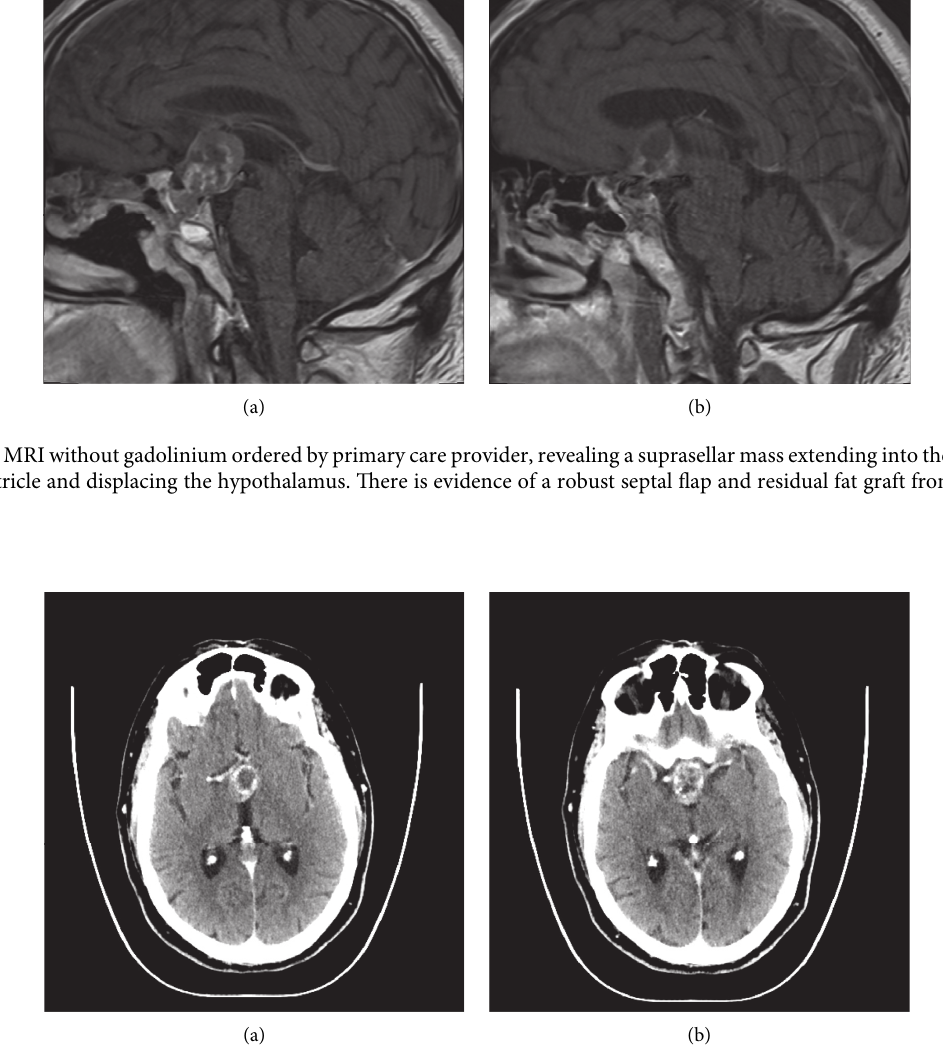
Figure 2: CT with contrast obtained by neurosurgery and otolaryngologist the day before surgery revealing a 2.7 cm × 2.3cm × 1.9cm suprasellar mass with peripheral calcifications. The mass impinges on the foramen of Monro and the anterior portion of the third